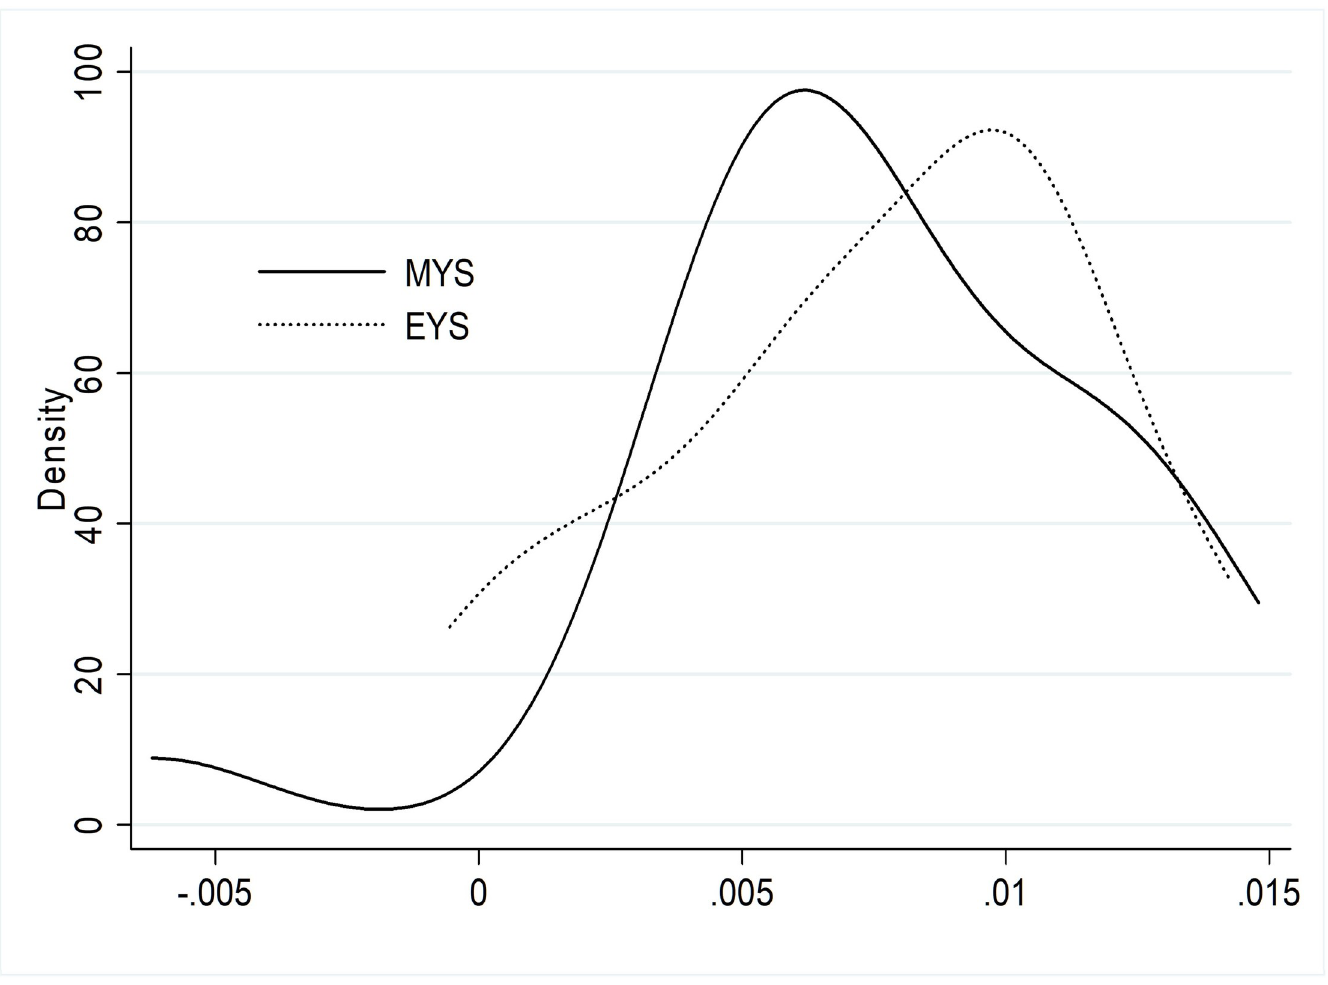
Fig 3. Provincial distribution of the annual mean variation between 2006 and 2014 of the mean years of schooling and the expected years of schooling indices. Notes: Each line represents the density function of the corresponding distribution. MYS = mean years of schooling index; EYS = expected years of schooling index.